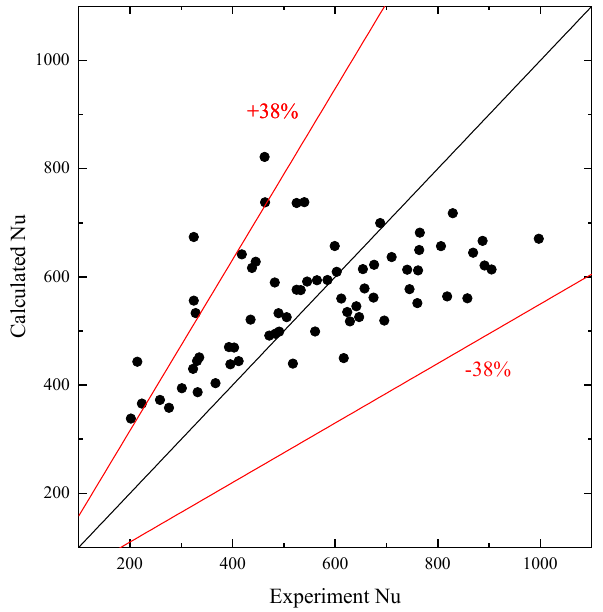
Figure 25. Comparison of fitted and experimental values when fitting the correlation equation using Re and Pr.